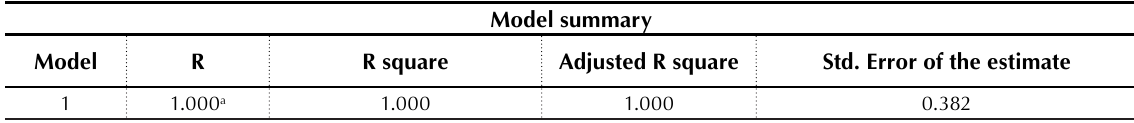
Table 4. Multiple regression model of the adjusted EVA